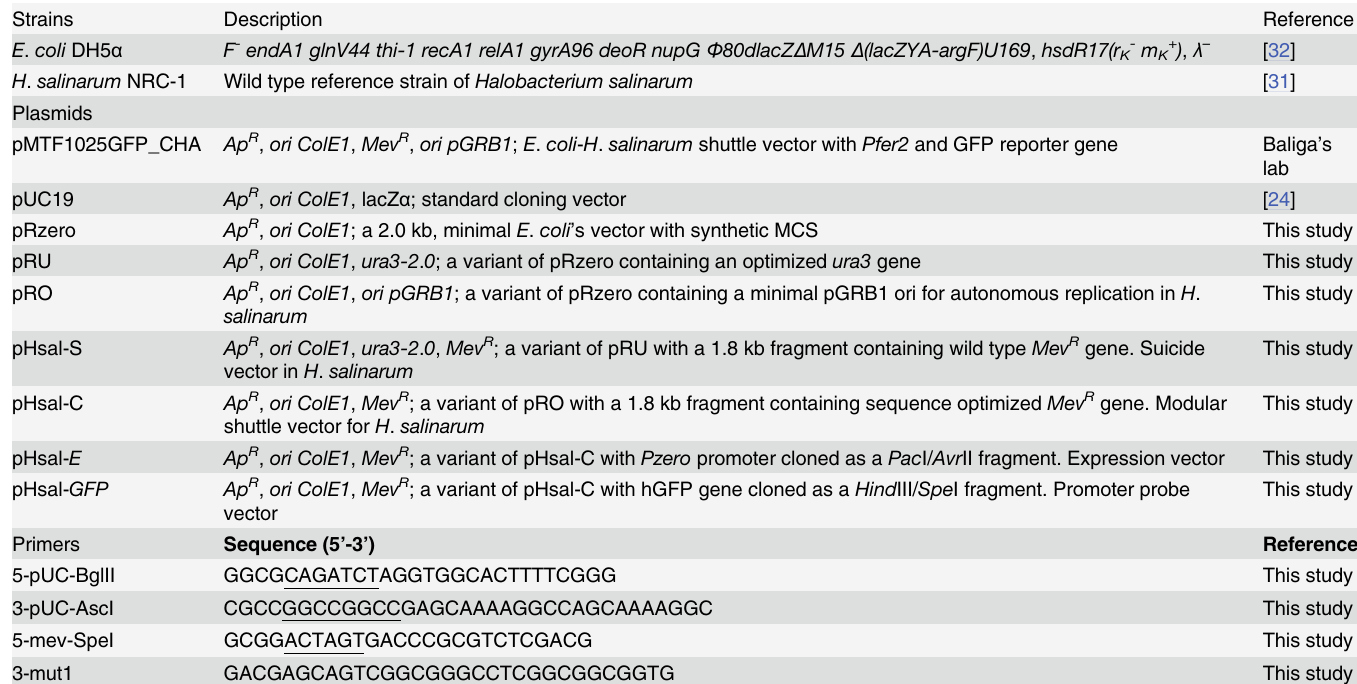
Table 1. Strains, plasmids and primers used in this